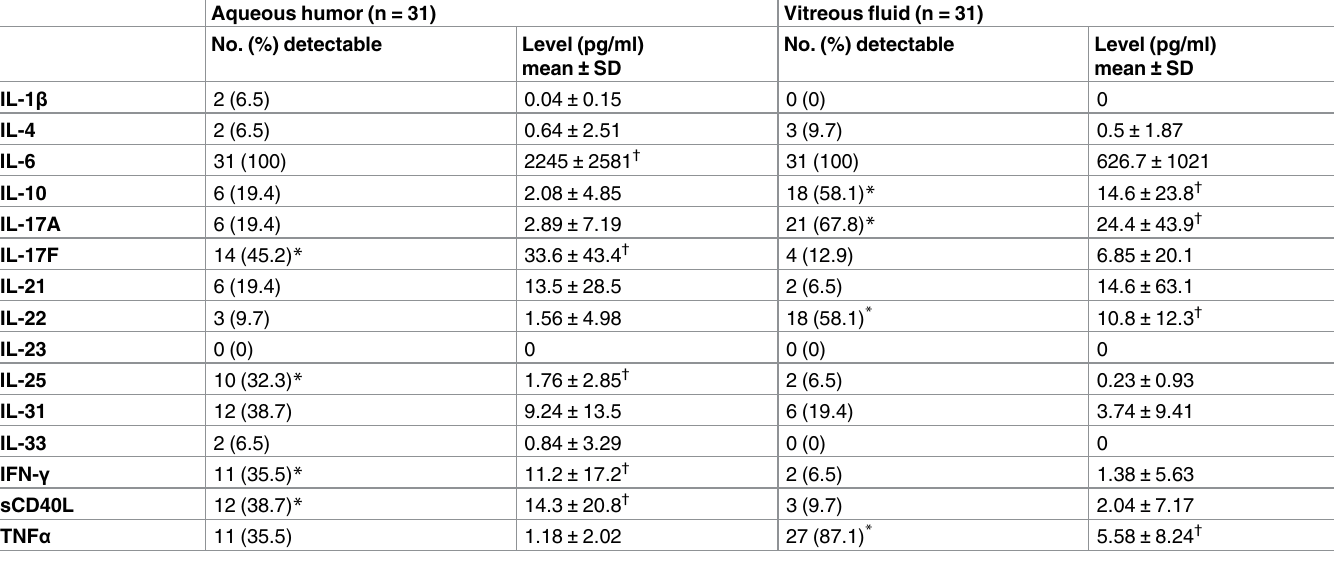
Table 1. Cytokines detected in aqueous humor and vitreous fluid samples collected from patients with proliferative diabetic retinopathy. Aqueous humor (n = 31) Vitreous fluid (n =